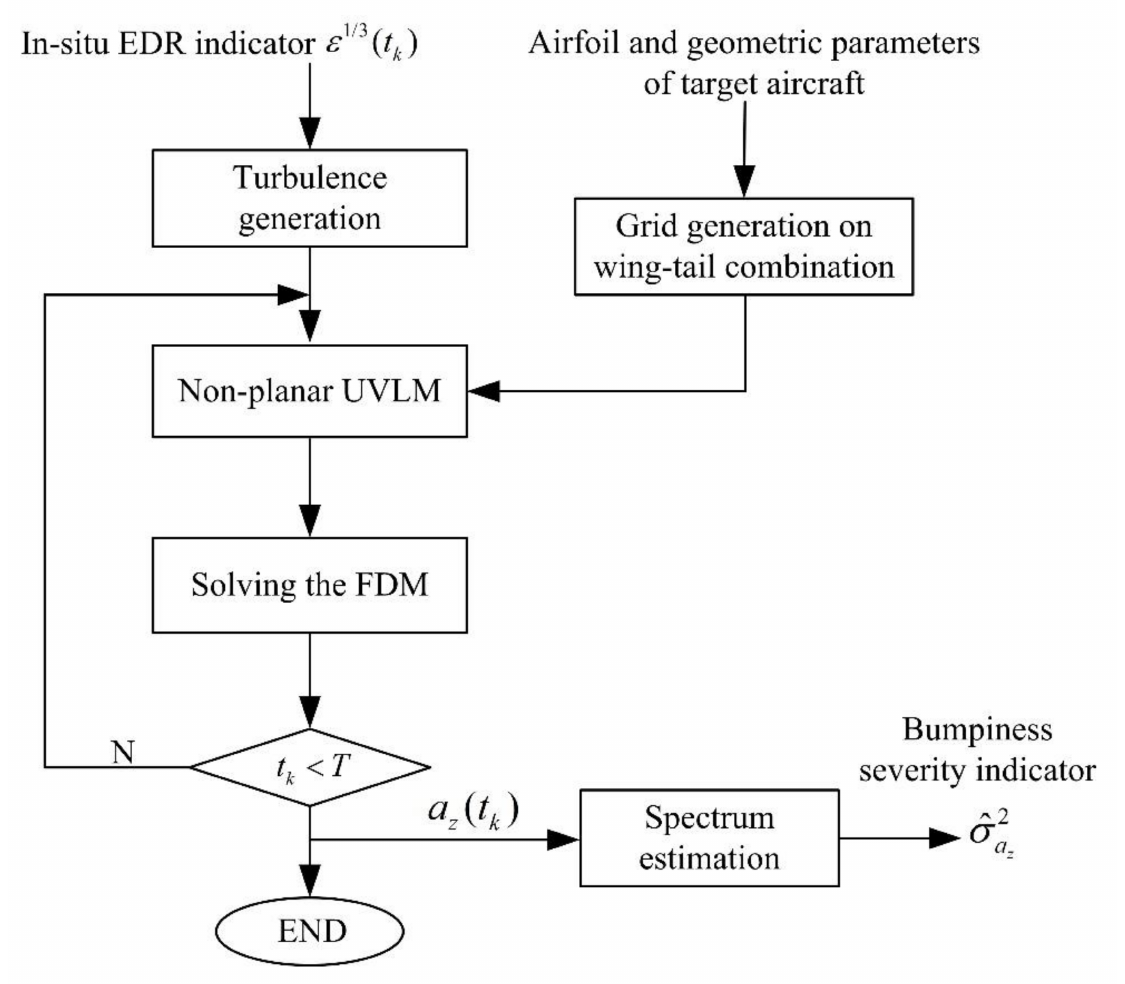
Figure 7. The computation